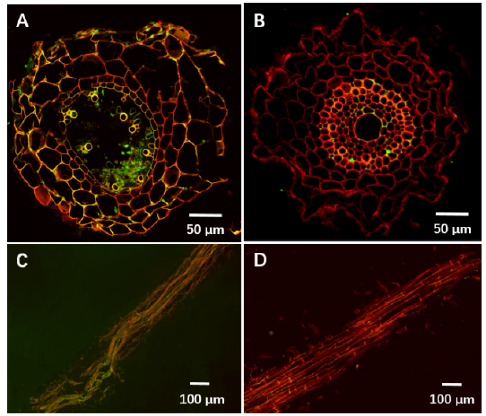
Figure 5. Effect of YB-185 on invasion of wheat roots by Fusarium pseudograminearum . ( A ) Light microscopy of cross-section of wheat root infected with F. pseudograminearum stained with wheat-germ agglutinin-Alexa Fluor 488 (WGA) to observe fungal hyphae by green fluorescence and propidium iodide (PI) to observe plant cell walls by red fluorescence; ( B ) cross-section of stained wheat root infected with F. pseudograminearum and treated with YB-185; ( C ) longitudinal section of stained wheat root infected with F. pseudograminearum ; ( D ) longitudinal section of stained wheat root infected with F. pseudograminearum and treated with YB-185.